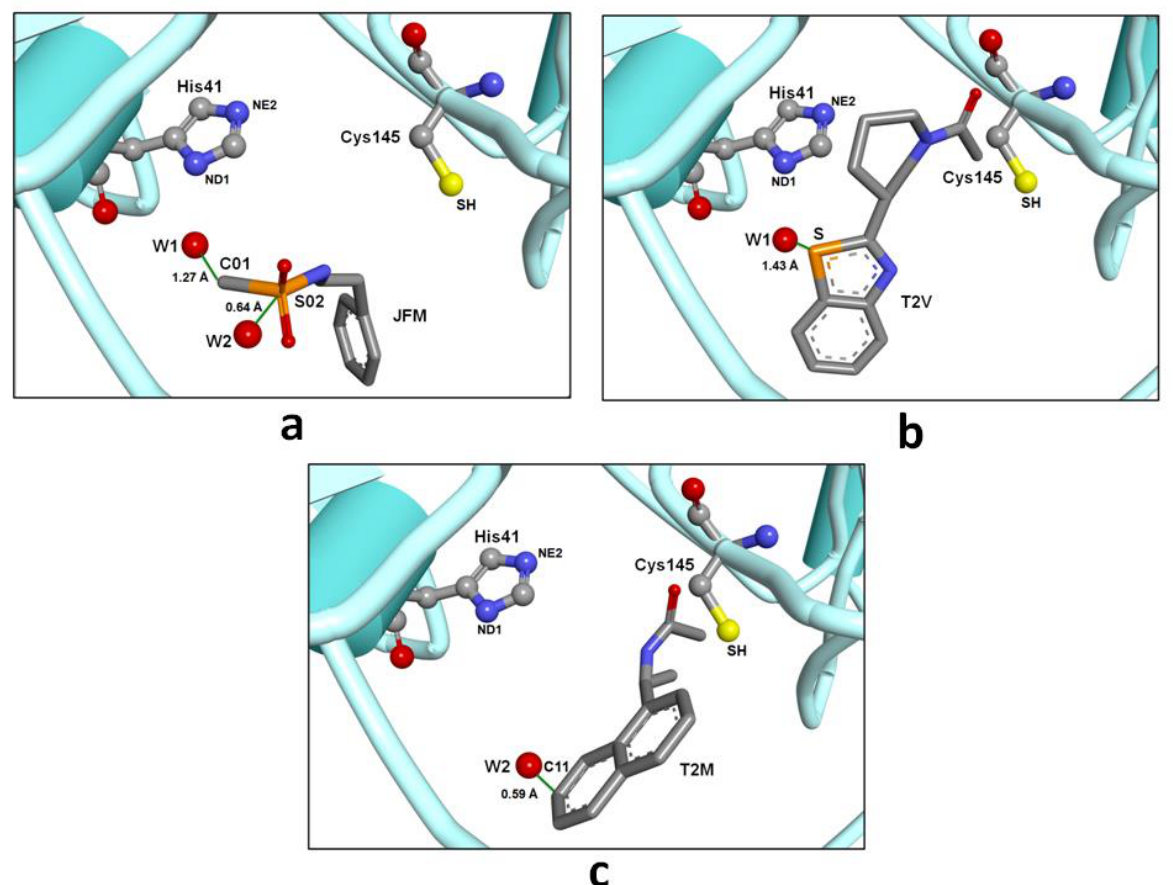
Figure 6. (a) The superimposed complex between the crystal structure of 6YB7 (ligand free form) and 5R7Y (ligand-bound from). The ligand JFM of 5R7Y has occupied the positions of W1 and W2. (b) The superimposed complex between the crystal structure of 6YB7 (ligand free form) and 5REN. The ligand T2V of 5REN has occupied the positions of W1. (c) The superimposed complex between the crystal structure of 6YB7 (ligand free form) and 5REW. The ligand T2M of 5REW has occupied the positions of W2. (The green continues lines explore the distances between two atoms are within